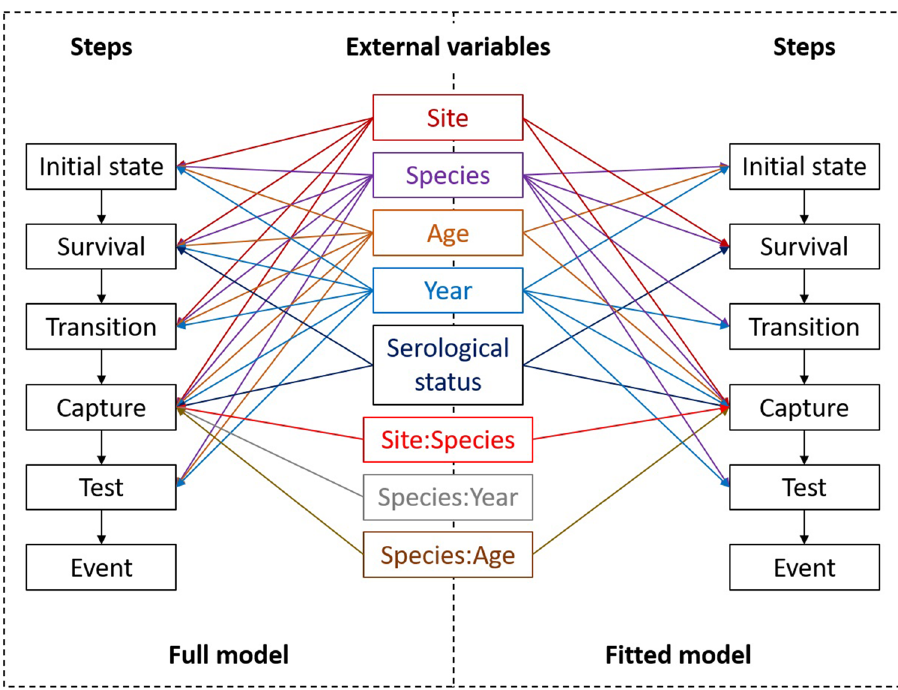
Figure 2. Structure of the full and best-fitted models with external variables tested. The colon “:” refers to adjacent variables that were tested in